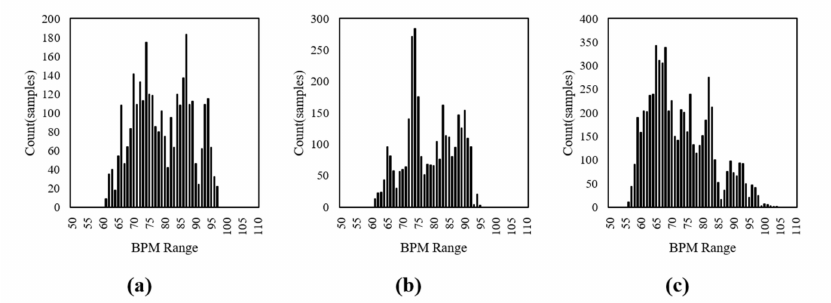
Figure 6. Distributions of the dataset extracted from the three experiments. ( a ) Experiment 1: normal, ( b ) experiment 2: facial expressions, ( c ) experiment 3: facial expressions and voluntary head motions.